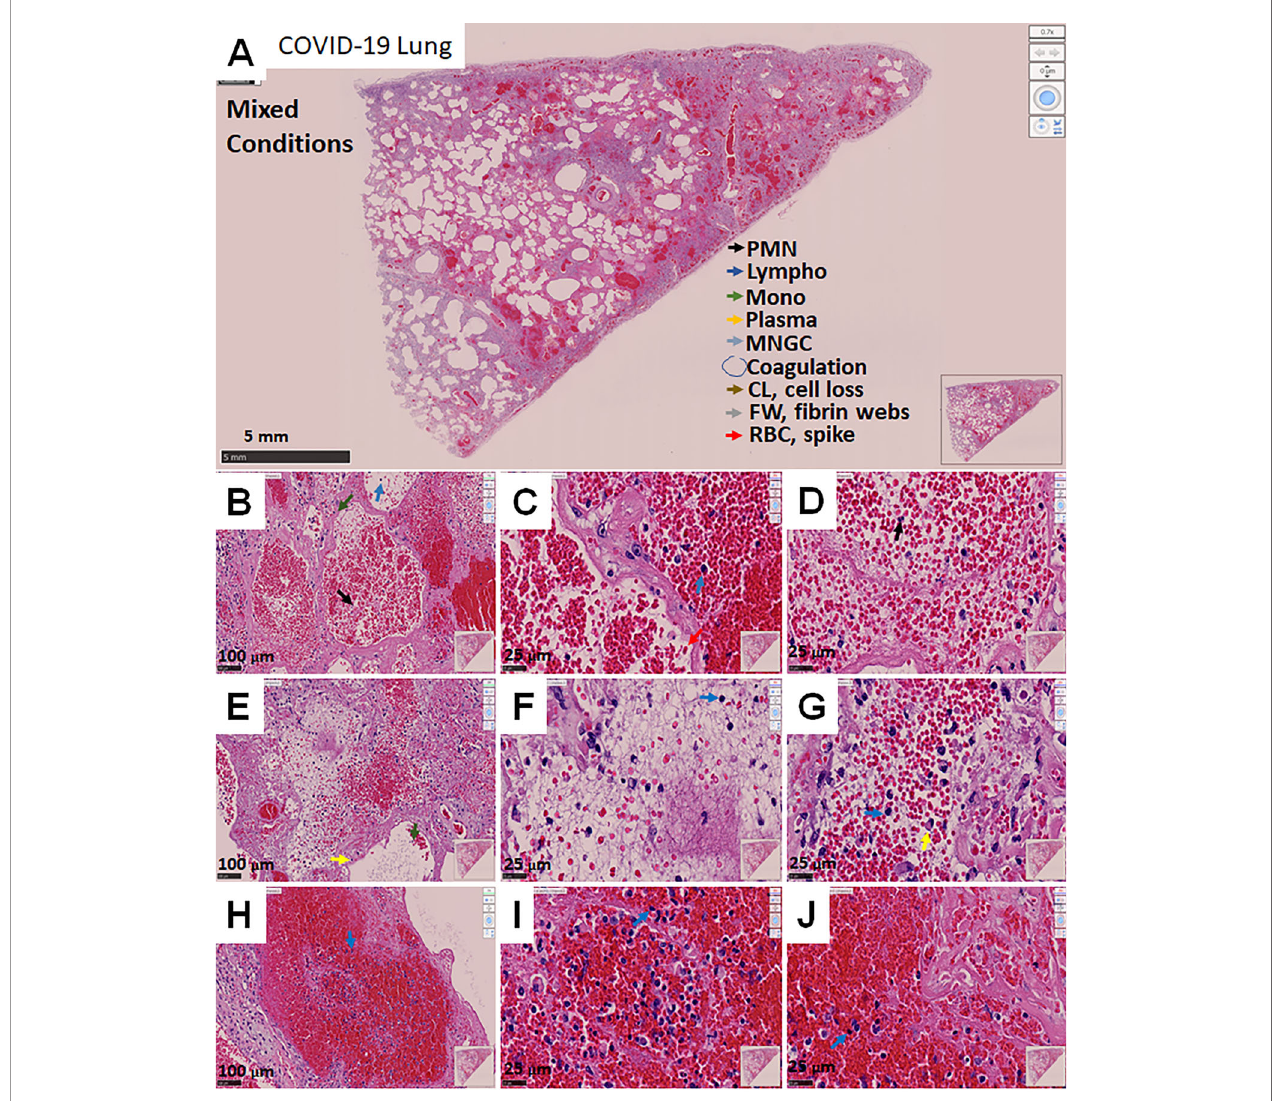
FIGURE 3 | Representative microphotograph of eight serial sections of lung obtained from a deadly case of COVID-19, with mixed conditions, with hemorrhagic lesions, fi brosis, immune in fi ltration, fi brin webs, and signi fi cant lung damage. (A) Representative H&E-stained images of lung classi fi ed as mixed conditions due to the combination of phenotypes I and II. (A) Low magni fi cation allows us to appreciate the degree of damage, hemorrhagic, fi brosis, intravascular coagulation webs trapping immune cells within the blood vessels. Bar: 5 mm. (B – D) Correspond to higher magni fi cation to denote the intravascular and hemorrhagic parenchymal lesions. Bar 100 µm and 25 µm. (E – G) Correspond to intravascular areas. Bar 100 µm and 25 µm. (H – J) represent contained hemorrhagic lesions within the parenchyma. Due to these characteristics, we named this phenotype mixed conditions. As indicated in A, arrows of different colors indicate representative cell types, areas with coagulation, cell loss (CL), Fibrin webs (FW), and red blood cells with spikes (RBCs). n=4 different individuals with 15-20 serial